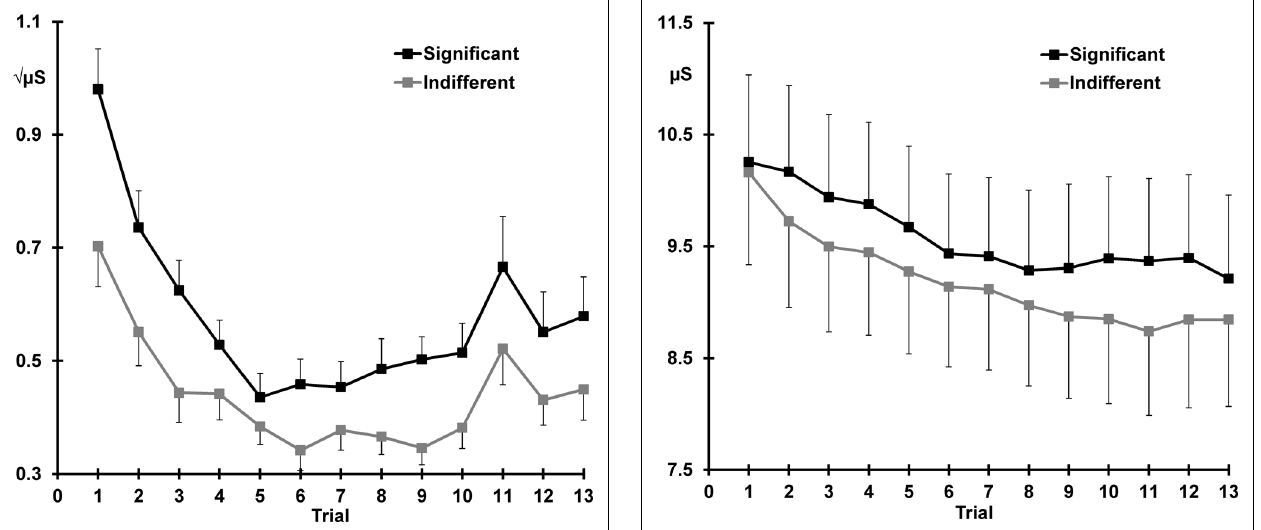
= 0.64; quadratic trials: F = 8.26, F = 41.50, p < 0.001, η 2 p = 0.26). There was a main effect of condition across p = 0.009, η 2 p